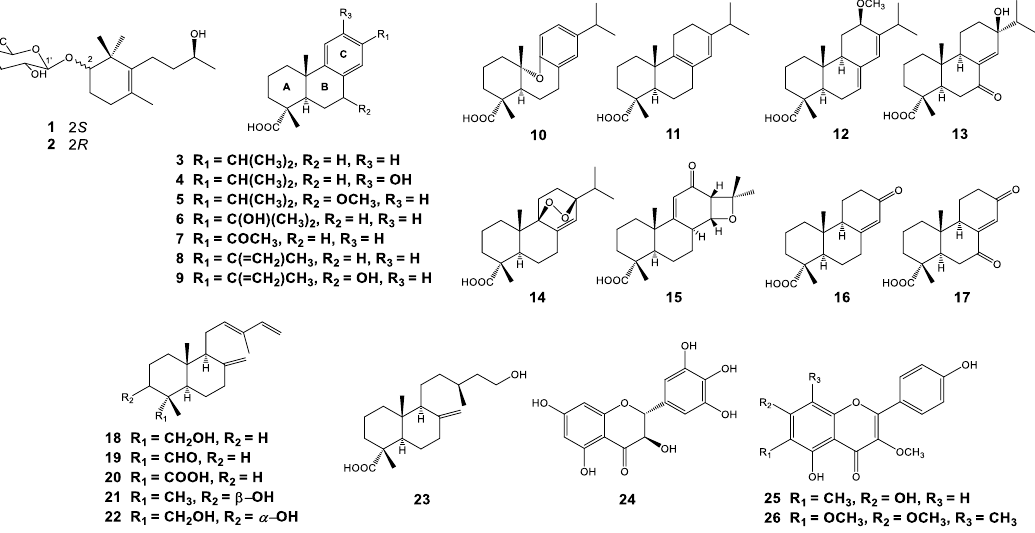
Figure 2. Chemical structures of compounds isolated from Pinus densiflora .